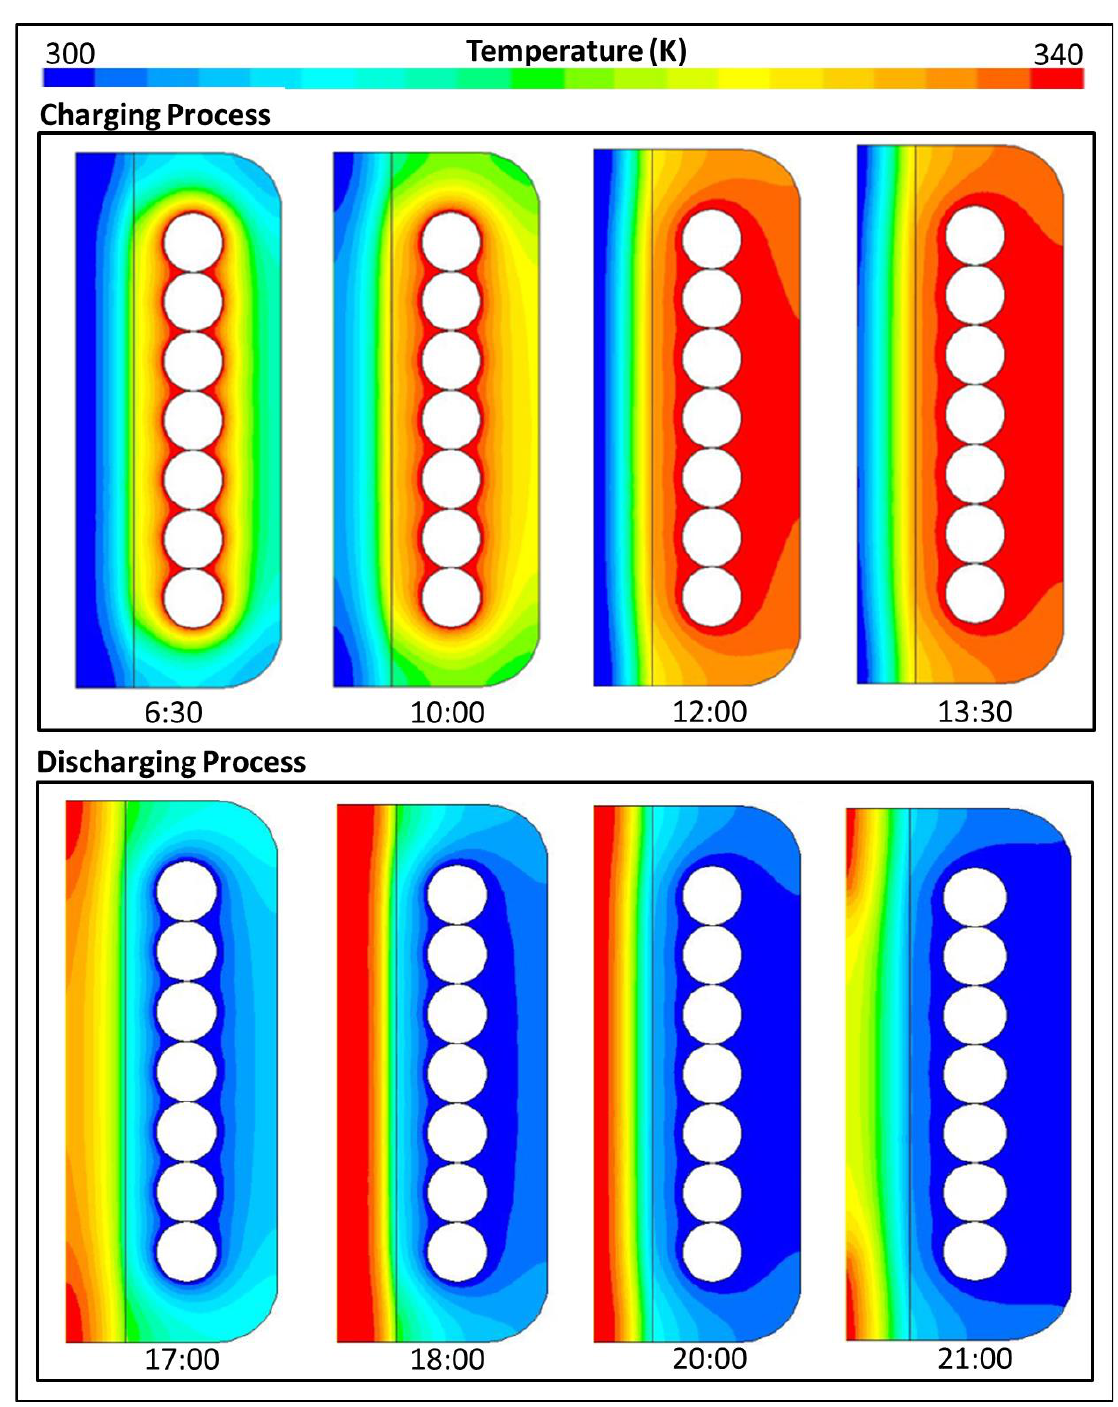
Figure 5. Time distribution of the temperature of the SWH – PCM system at selected times.